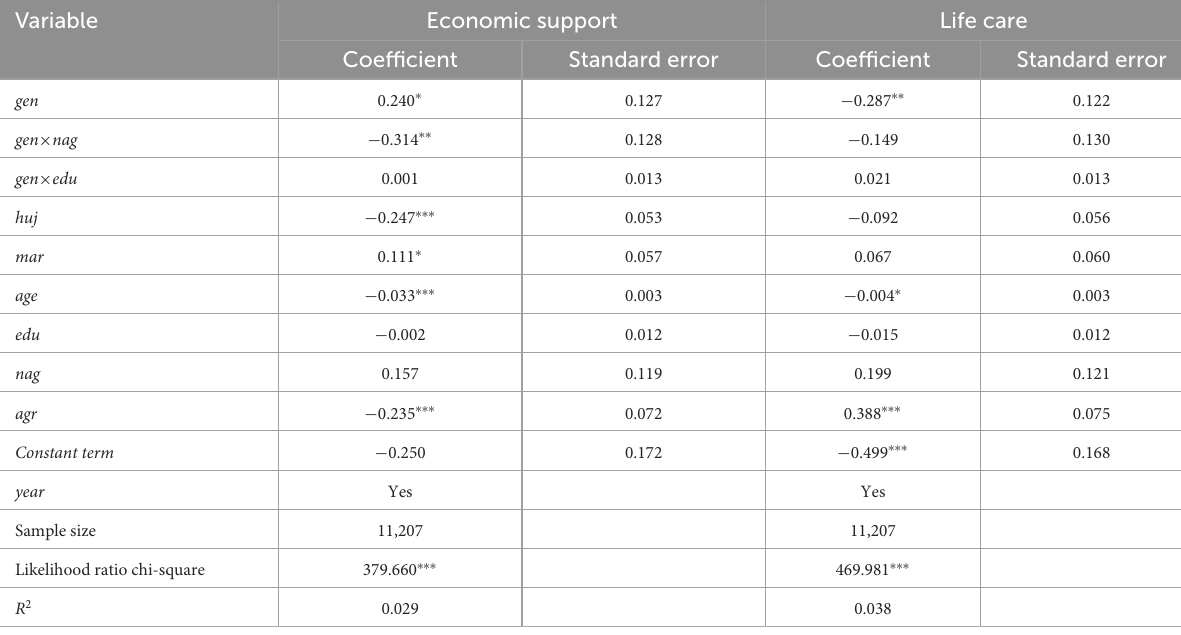
TABLE 6 Estimated results of the impact of children’s socioeconomic status on parental pension. Variable